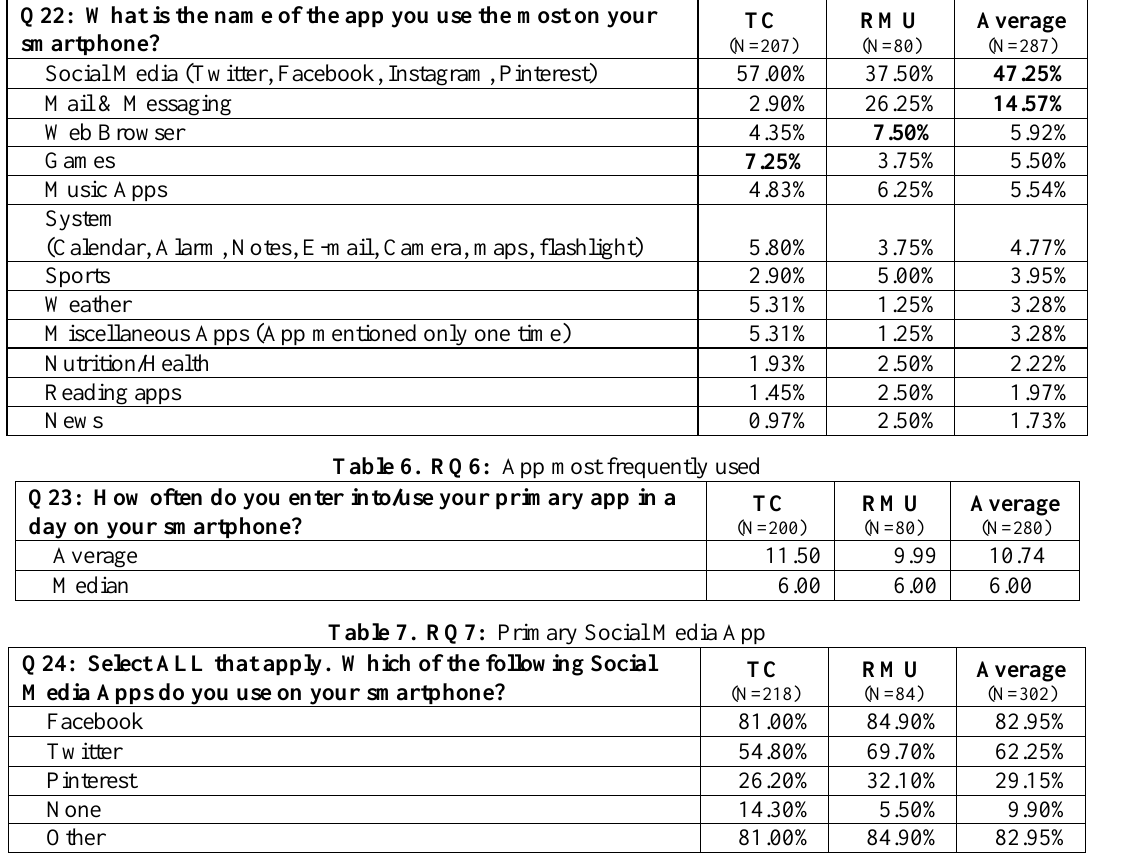
Table 5. RQ5: App most frequently used